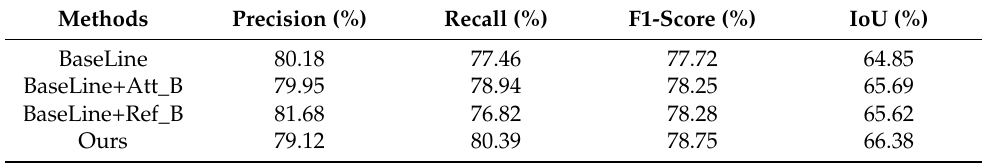
Table 5. Ablation validation on the DeepGlobe test